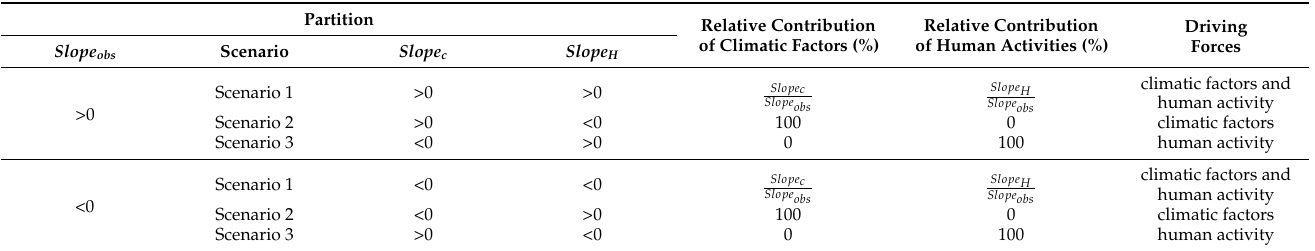
Table 1. Methodology for calculating the relative contribution of different factors to changes in vegetation